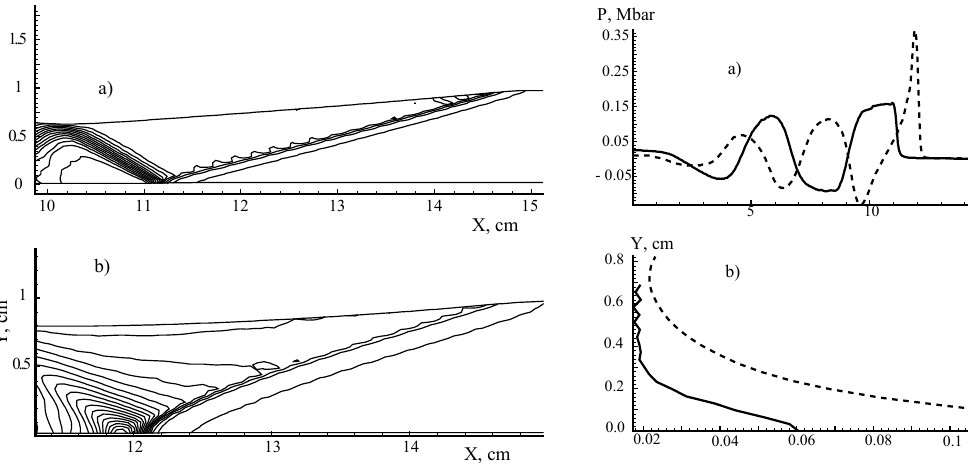
Figure 7: Pressure profile (a) and longitudinal-velocity profile ( ) u y (b) for the planar and cylindrical geometries (solid x and dashed lines, respectively).